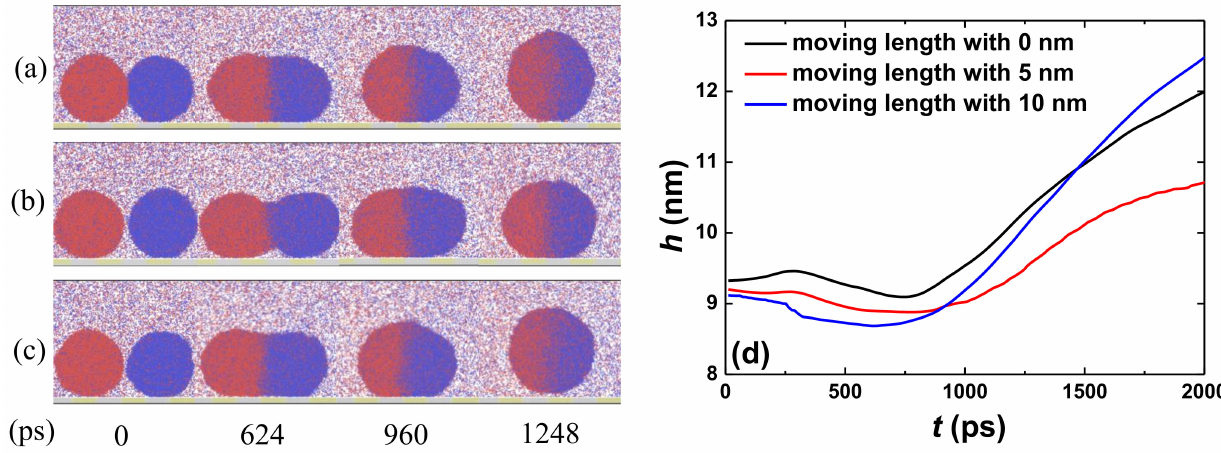
Figure 5. Snapshots of the coalesced droplets at L b = L l = 6 nm, θ l = 160 ◦ : ( a ) the center is unmoved; ( b ) the center is moved by 5 nm; ( c ) the center is moved by 10 nm; ( d ) evolution of the droplets height of mass center with different moving